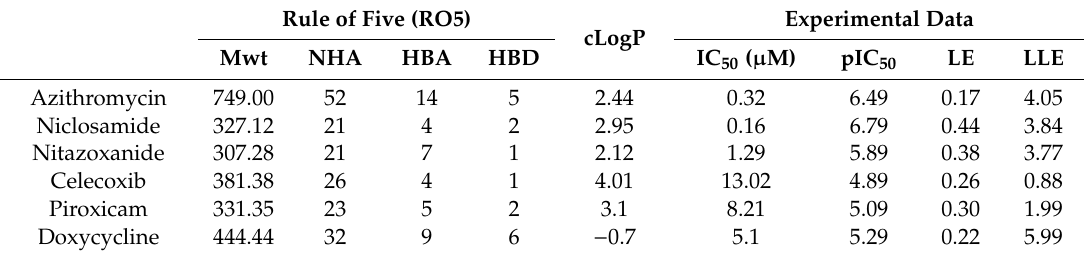
Table 4. Summary of ligand e ffi ciency scores of the target drugs against SARS-CoV-2. Rule of Five (RO5)